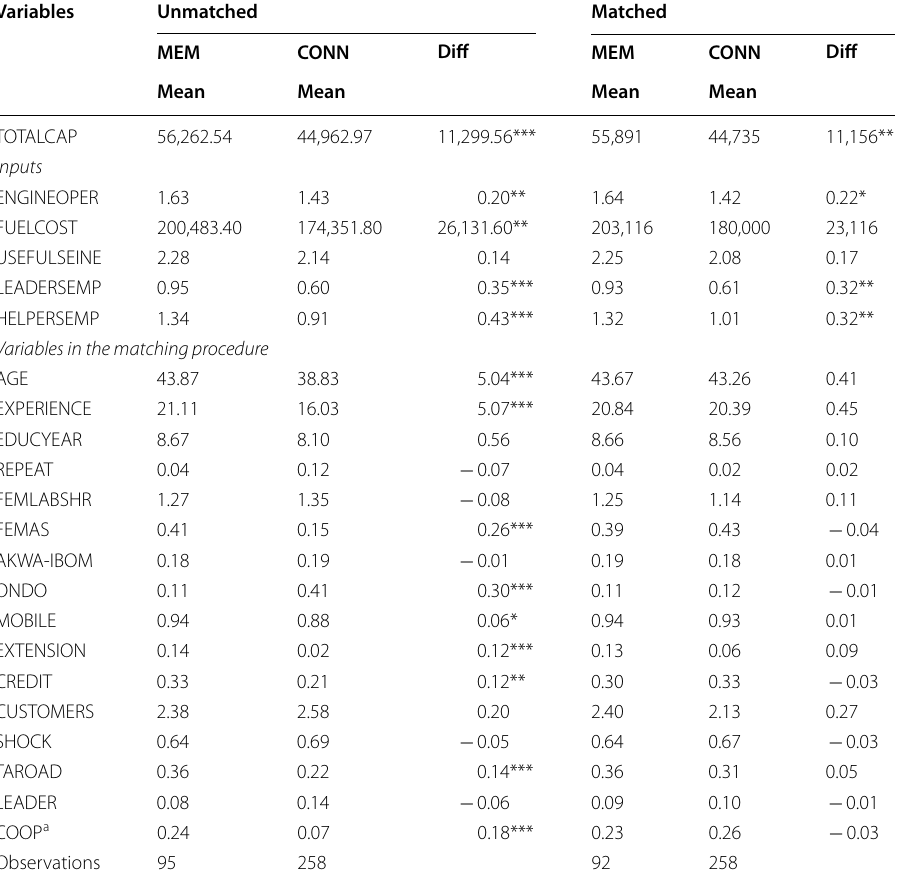
Table 2 Descriptive statistics of key variables in the matching